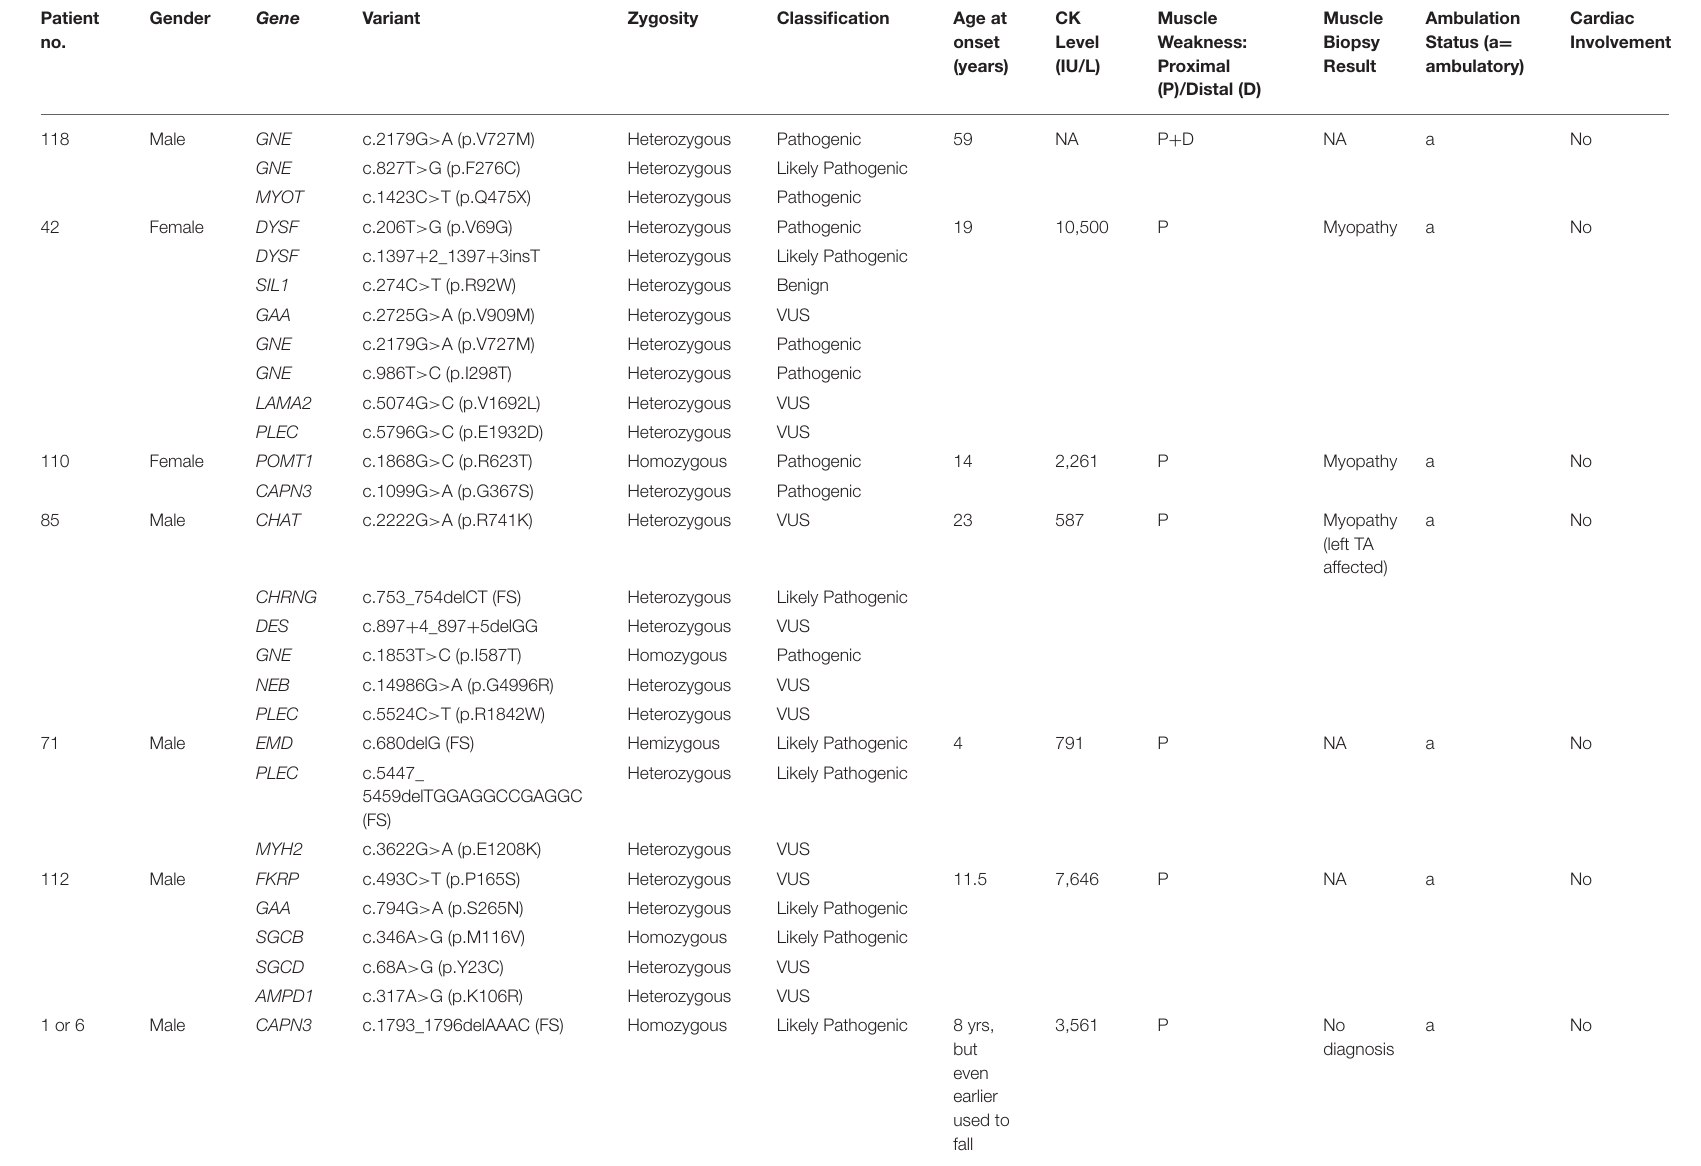
TABLE 5 | Clinical symptoms and genotype of patients with pathogenic variants in more than one gene. Patient